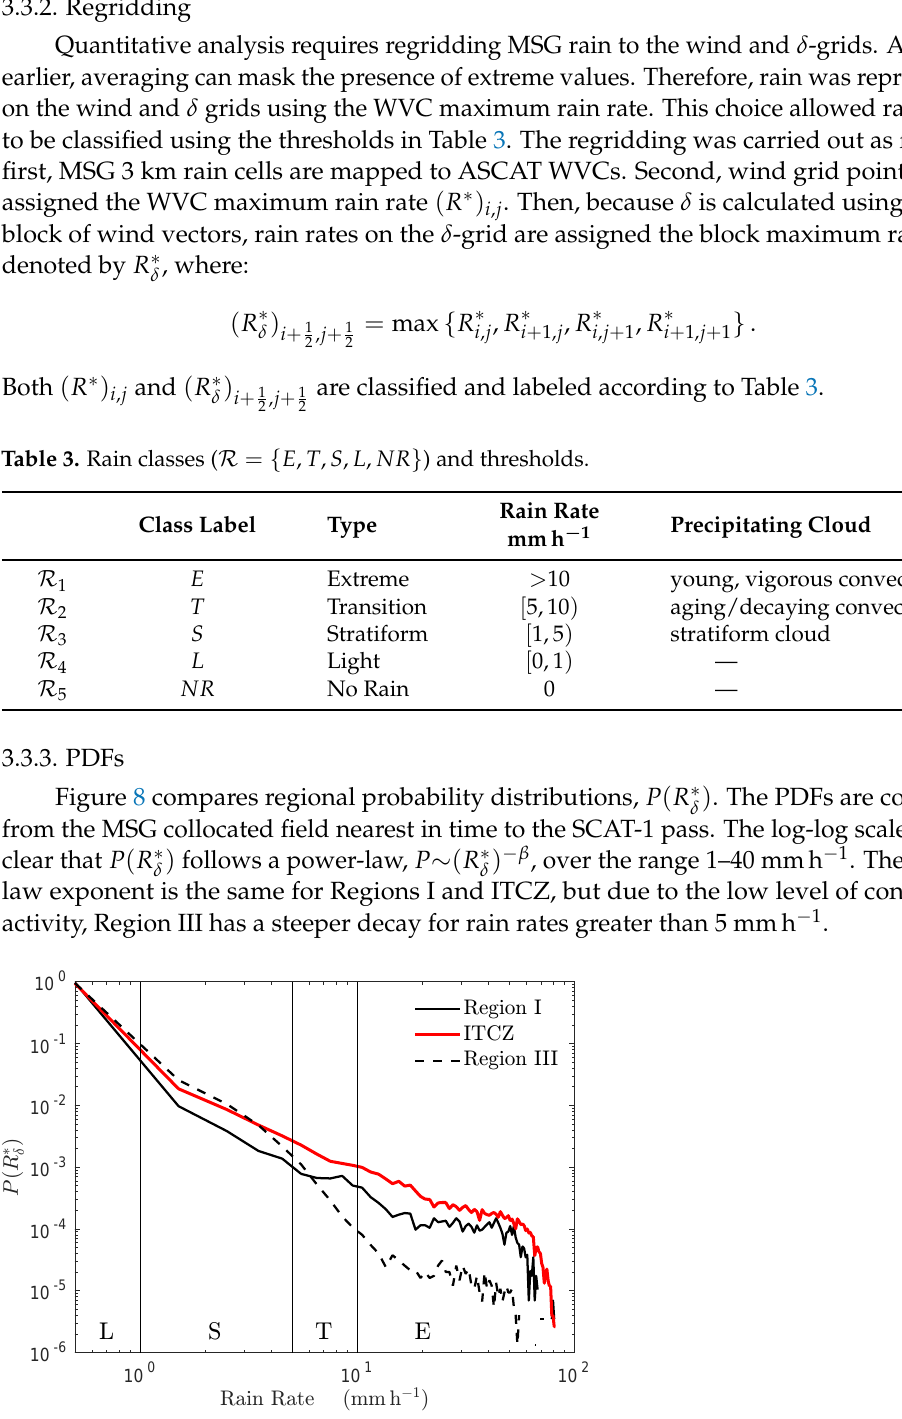
) , for Regions I, ITCZ, and III (December 2012). Rain δ